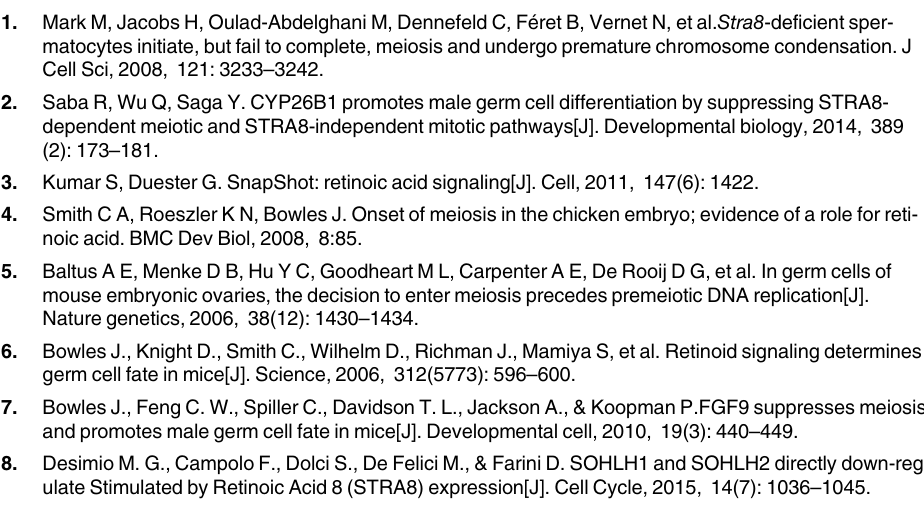
S1 Table. The sequences of primers used to construct the Stra8